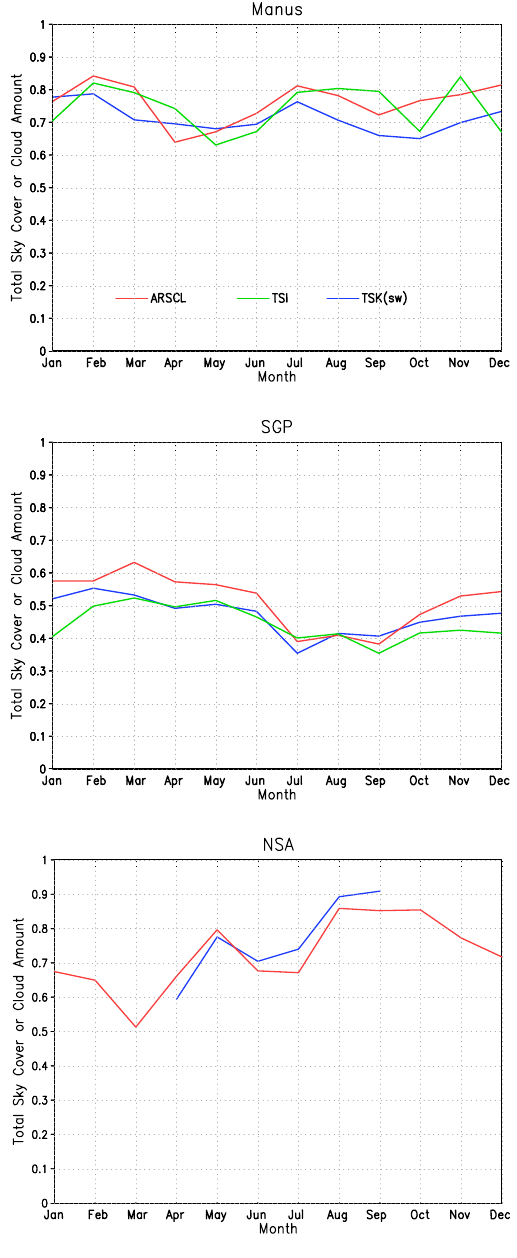
Fig. 3. The multiple-year averaged monthly mean total sky cover or cloud fraction from ARSCL, TSI and TSK over Manus (top), SGP (middle) and NSA (bottom),